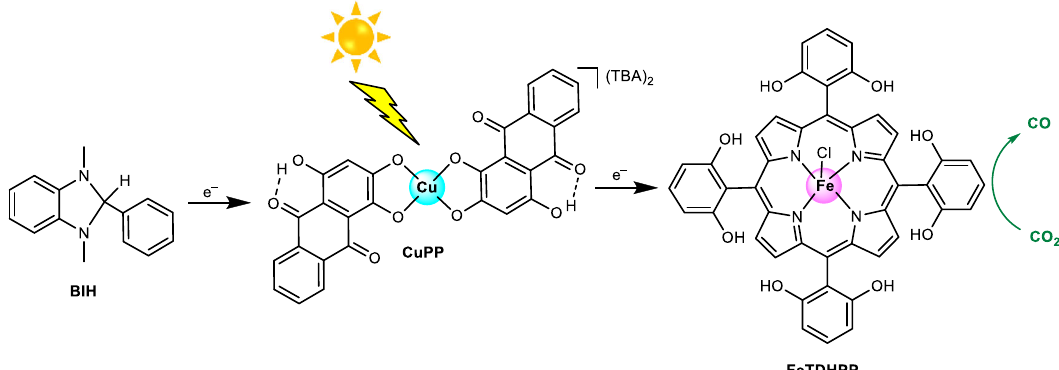
Fig. 1 Illustrative scheme of the photocatalytic CO 2 reduction system. BIH is the sacri fi cial reductant, and CuPP is the photosensitizer, and FeTDHPP is the catalyst investigated in this study.